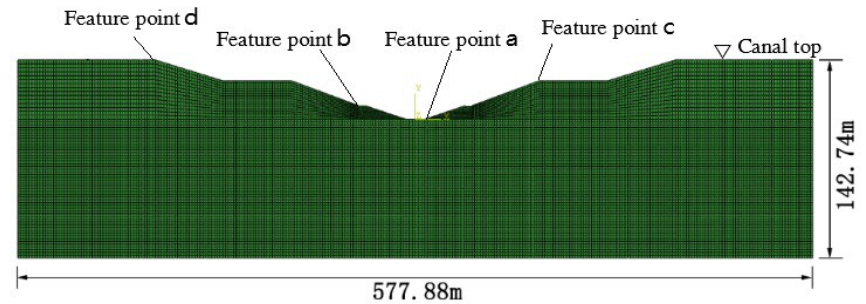
Figure 3. Three-dimensional finite element model of a typical section of the deep excavated canal.